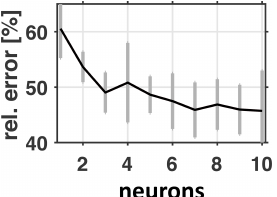
Figure 18. ANN error relative to naive persistency forecast versus the number of neurons in the hidden layer. The black line features the best ANN parameter setting found within an ensemble of 30 optimizations for each of the number of neurons tested. The gray bars denote the ensemble’s standard